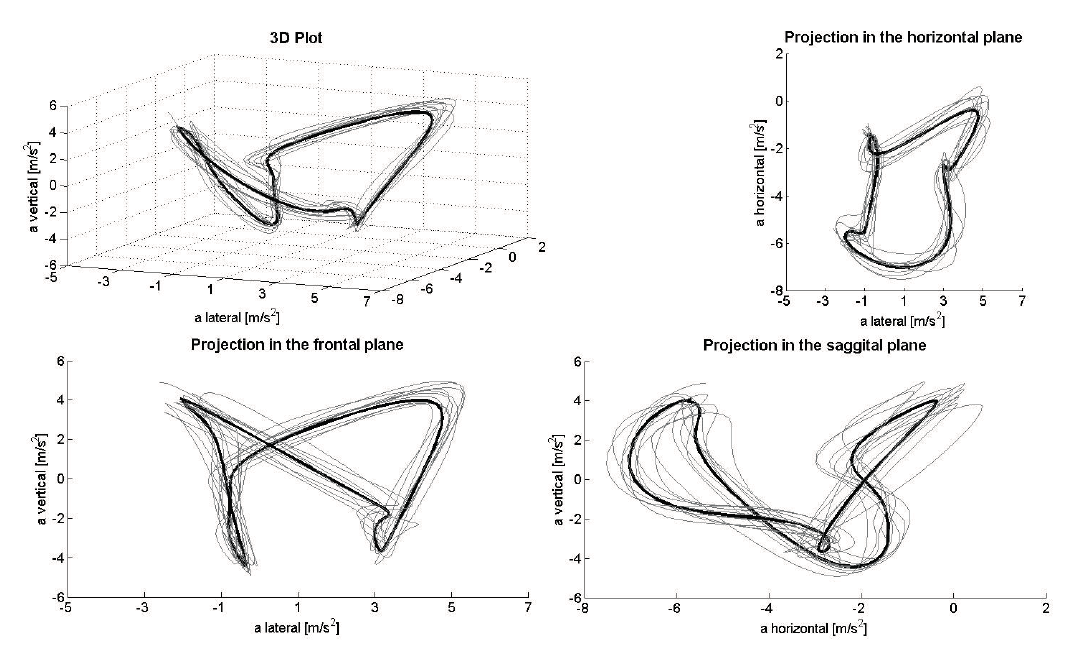
Figure 4. Acceleration data during G4L in the total space ( upper left ) and frontal ( lower left ), horizontal ( upper right ) and sagittal planes ( lower right ).